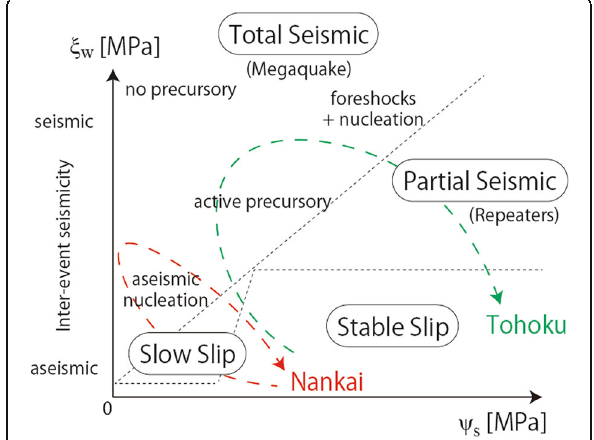
Fig. 10 Schematic phase diagram of seismicity. The two curving arrows represent along-dip variations in frictional heterogeneity in the Nankai (red) and Tohoku (green) subduction